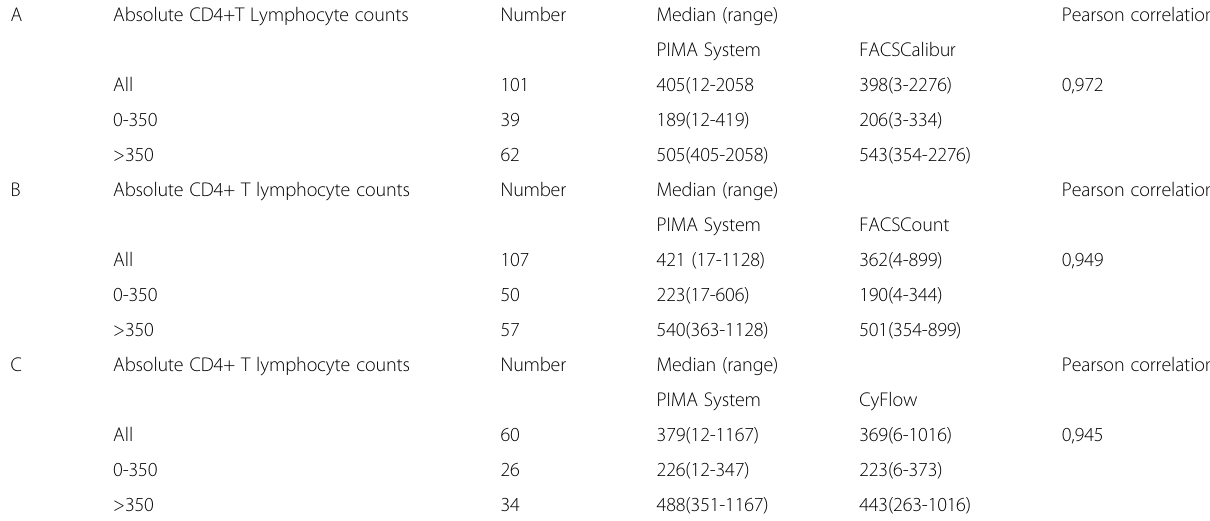
Table 2 Median of absolute CD4+ T lymphocyte count in all blood samples and the absolute CD4+T – Lymphocyte count range of 0-350 and greater than 350cell/ μ L determine by the PIMA and other predicate flow cytometry